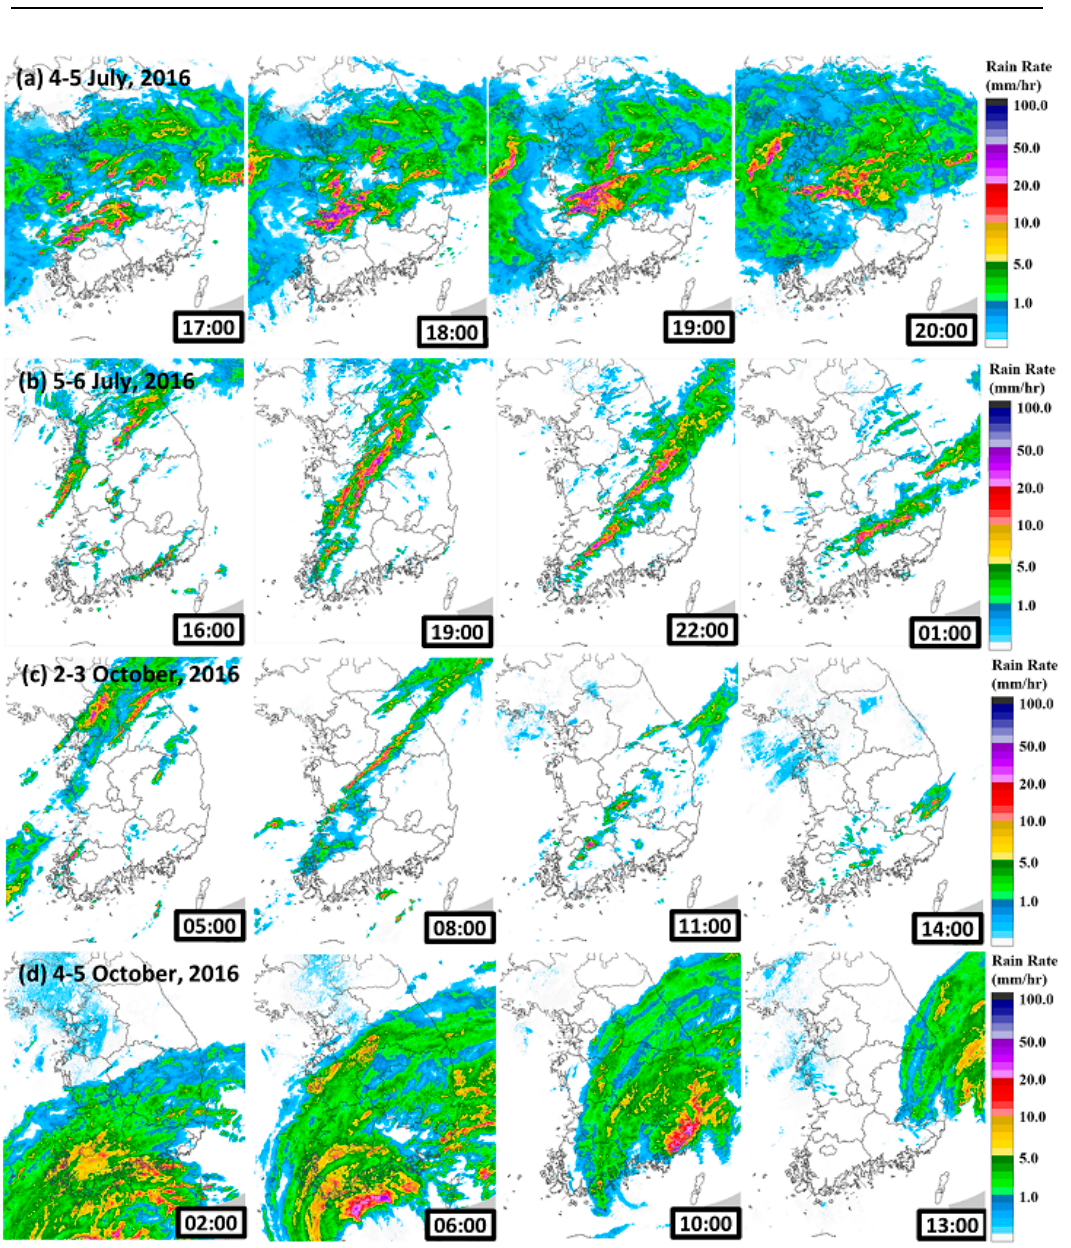
Figure 4. Radar images of four storm events considered in this study.